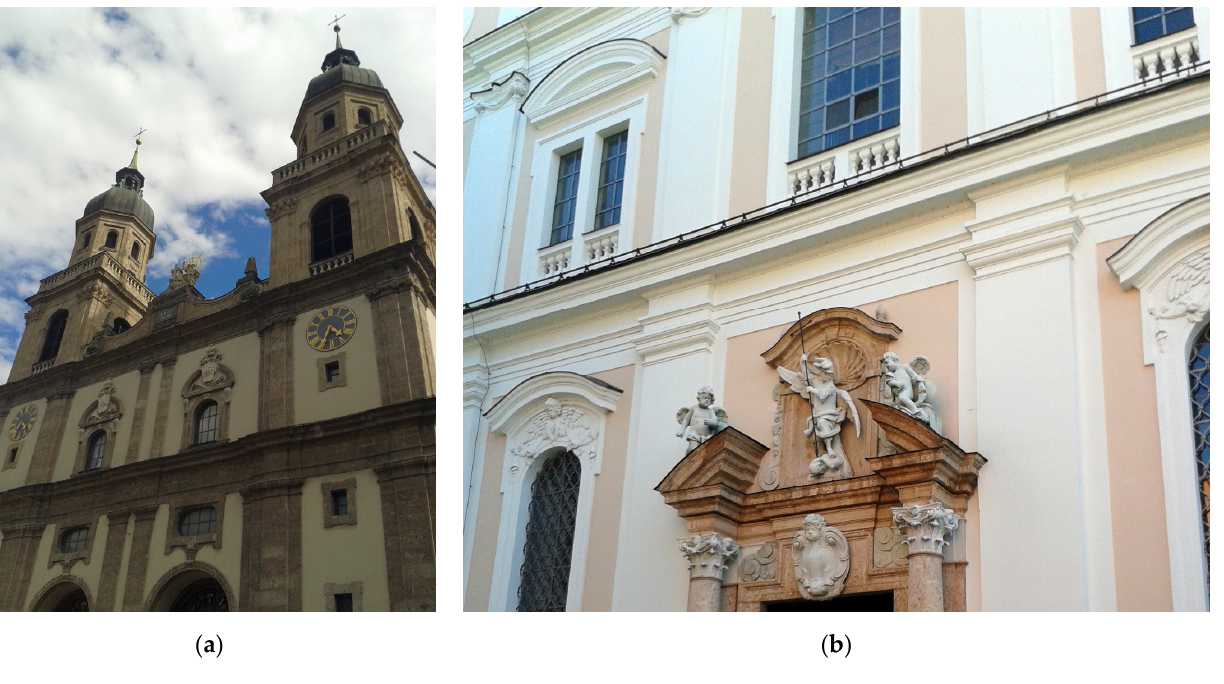
Figure 8. Monochromatic architectural order on colored walls: ( a ) creped entablature in sandstone architectural order—the façade of the Jesuit church in Innsbruck (1627–1646); ( b ) white order on pink walls—the façades of the Jesuit church in Pasava (1677). Photos by author.